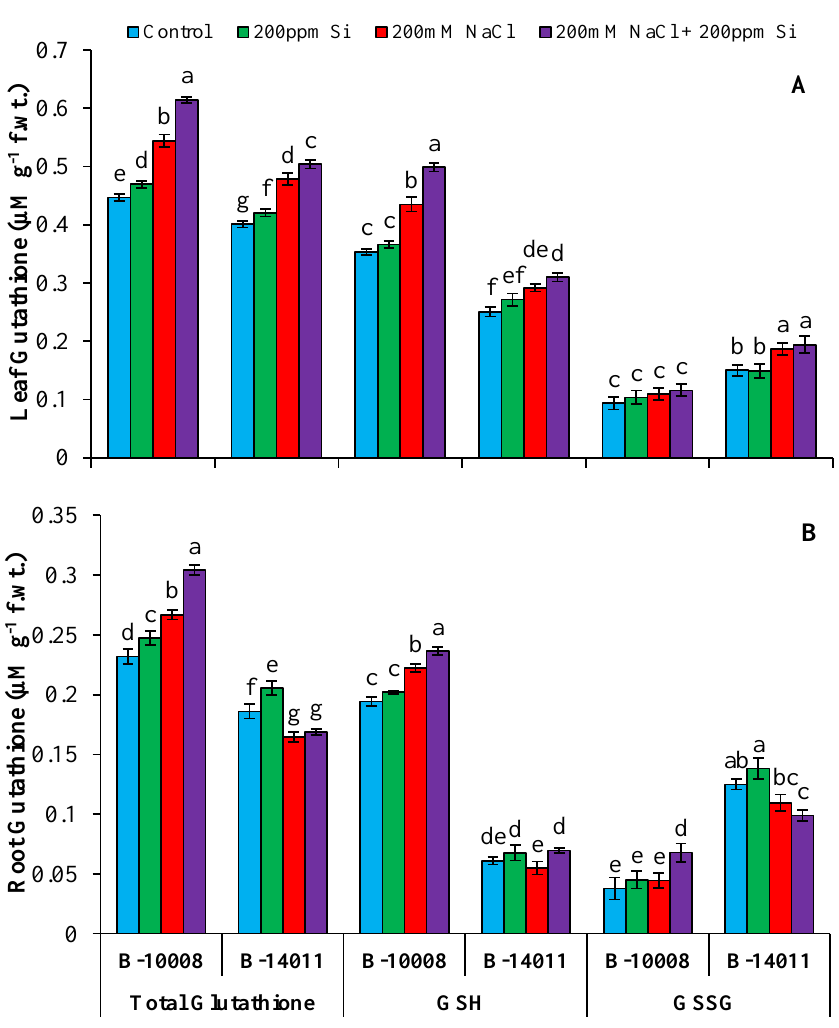
Figure 3. Glutathione ( µ mol g − 1 f.wt.) contents in leaf ( A ) and root ( B ) of barley genotypes modulated by application of silicon through rooting media under salinity stress. The values represented by bars are means of four replicates ± SE. Different small letters (a–g) on bars denote significant difference at p ≤ 0.05 (Duncan’s multiple range test). Values sharing same letter within each subfigure are non-significant statistically. GSH = reduced glutathione, GSSG = oxidized glutathione, f.wt. = fresh weight. It has been observed that Si application under salinity stress more prominently